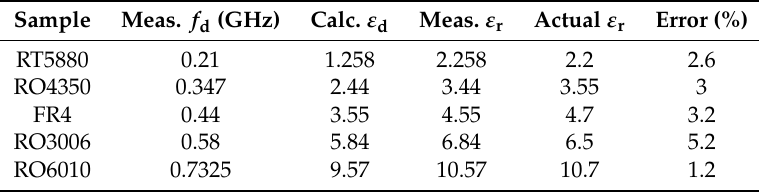
Table 1. Comparison between the measured permittivities of the samples under test and using (4) and the actual values taken from the commercial